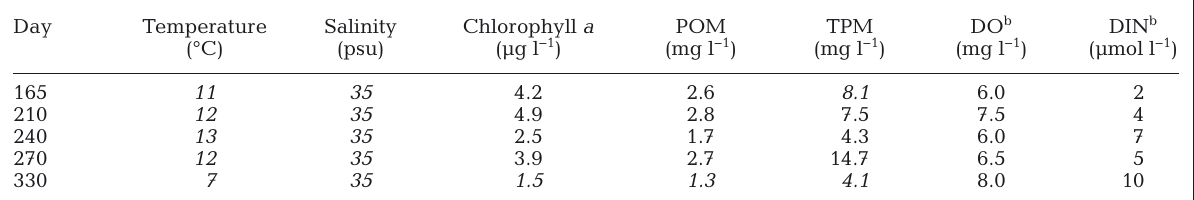
Table 2. Data used to run the Manila clam AquaShell individual model a , and the FARM model b for simulation of farm-scale